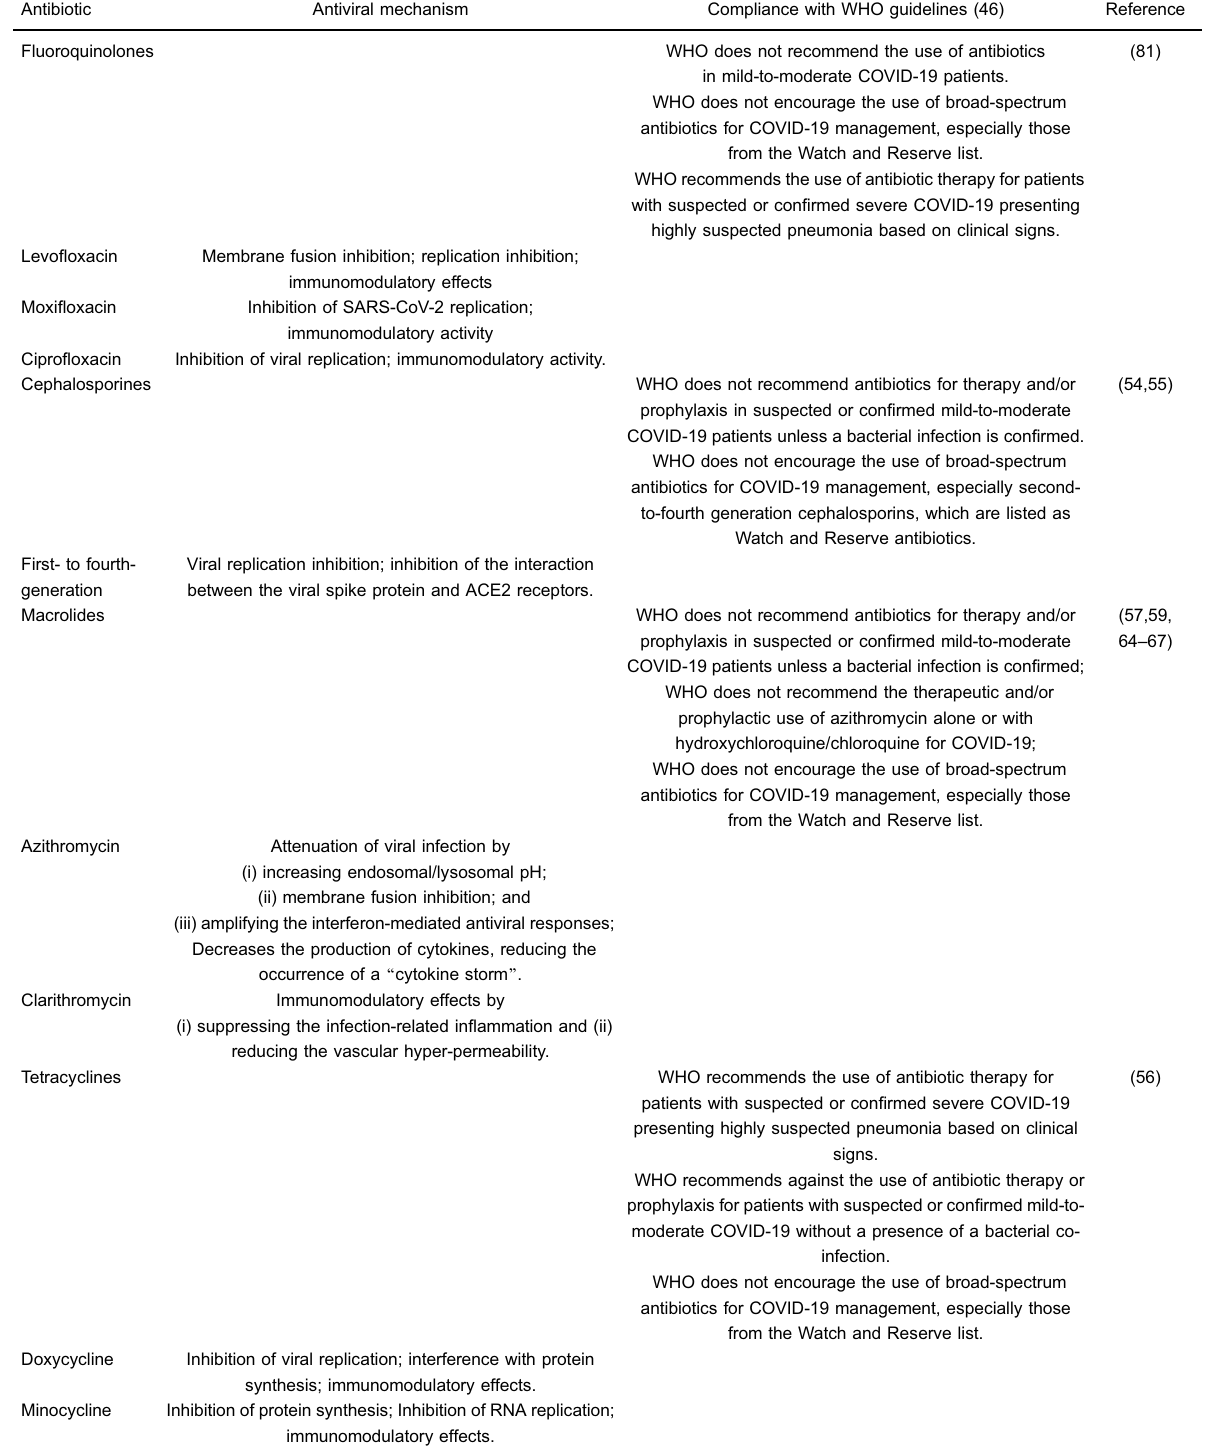
Table 2. Antibiotics with possible use in COVID-19 management.